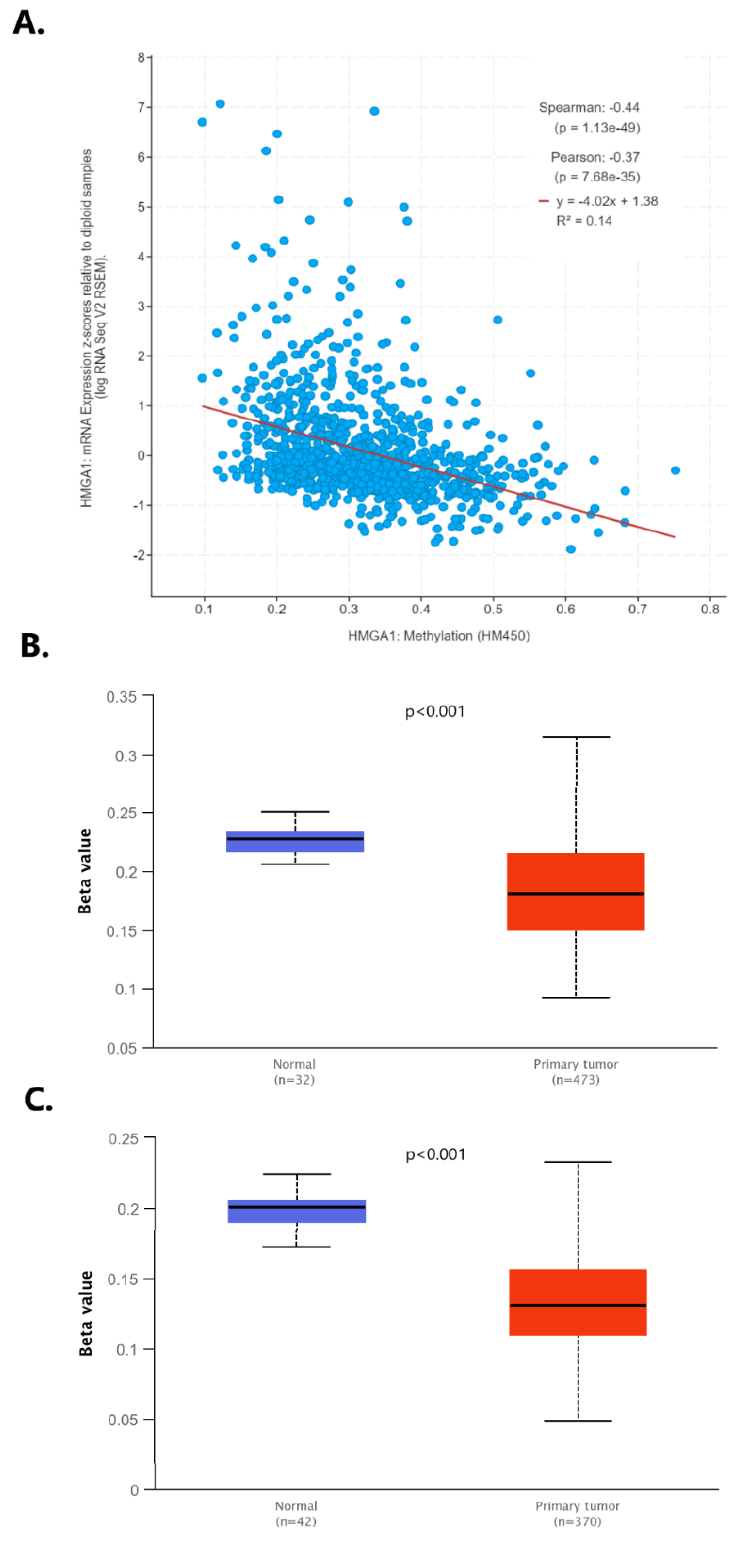
Figure 11. ( A ) Correlation between the mRNA expression level and DNA methylation profile of the HMGA1 in lung cancer by cBioPortal; the promoter methylation level of the HMGA1 in ( B ) lung adenocarcinoma and ( C ) lung squamous cell carcinoma tissue in comparison with normal lung tissue by UALCAN.